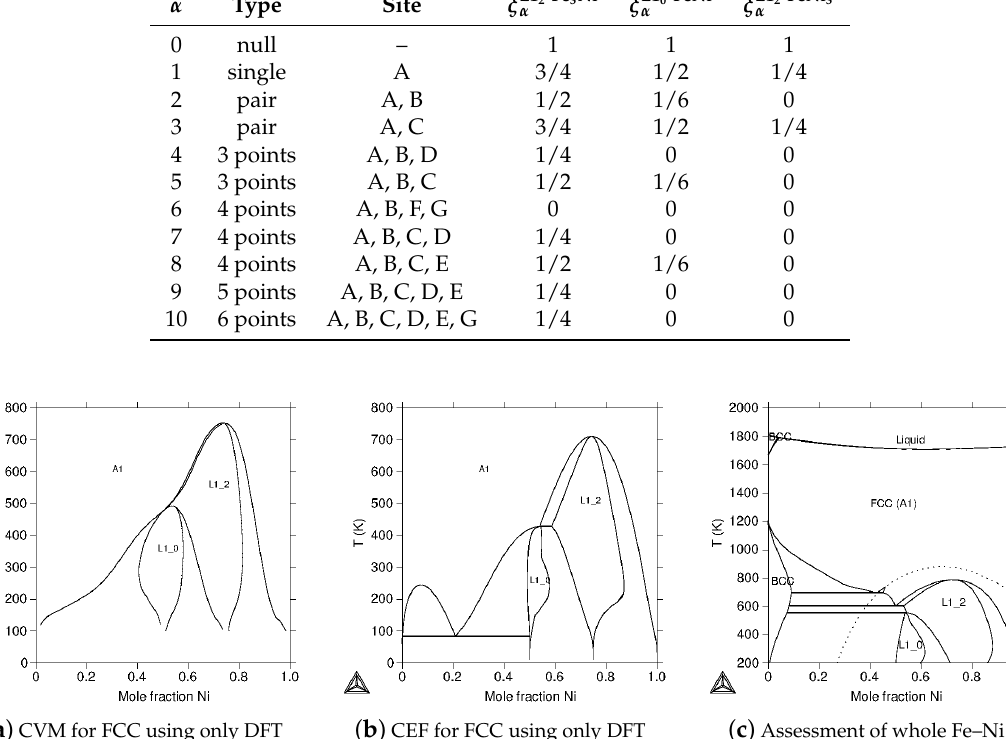
Table 1. Sub-clusters of the tetrahedron-octahedron (TO) clusters in FCC structure. Letters correspond to those in Figure 5. Specific values of correlation functions ( ξ α ) of L1 2 and L1 0 are also listed.